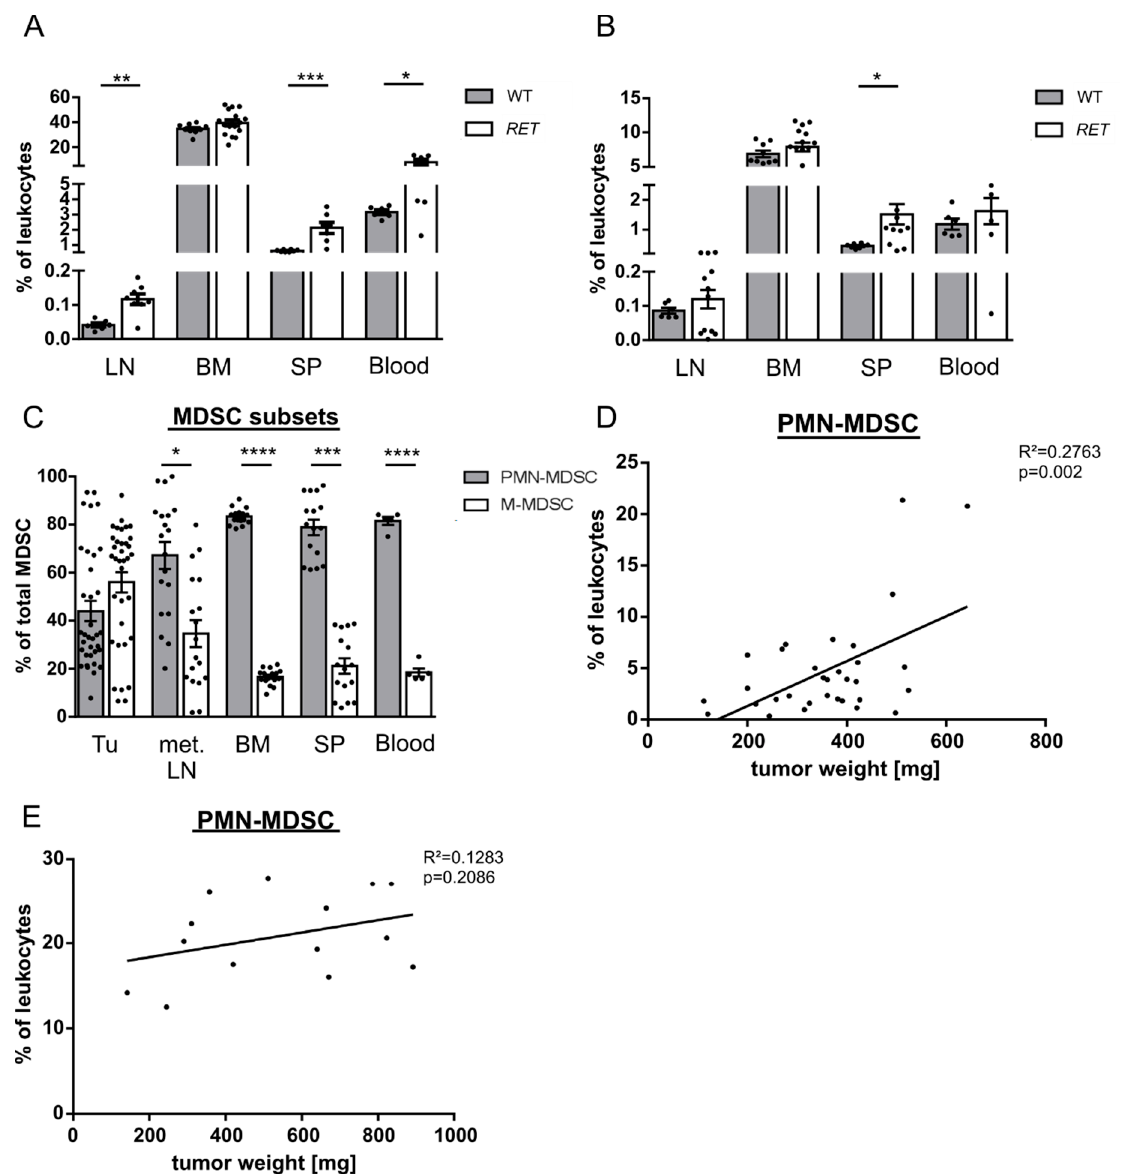
Figure 1. Myeloid-derived suppressor cells (MDSC) subpopulations in mice bearing melanoma or mesothelioma and their non-suppressive counterparts in healthy C57BL/6 mice. CD11b + Ly6G + Ly6C lo polymorphonuclear (PMN)-MDSC ( A ) and CD11b + Ly6G - Ly6C hi M-MDSC ( B ) of RET transgenic mice and their non-suppressive counterparts in C57BL/6 mice ( A , B ) were analyzed in lymph nodes (LN), bone marrow (BM), spleen (SP), and peripheral blood by flow cytometry. Data are presented as the percentage of PMN- or monocytic (M)-MDSC from tumor-bearing mice or their non-suppressive counterparts from healthy mice within CD45 + leukocytes (mean ± SEM; n = 6–16 mice/group). All samples were collected from tumor bearing mice in different time points between the appearance of macroscopically visible tumors and the appearance of abortion criteria. ( C ) PMN- and M-MDSC were measured in primary tumors (TU), metastatic LN (met. LN), BM, SP, and peripheral blood of RET transgenic mice and expressed as the percentage of PMN- or M-MDSC within total MDSC (mean ± SEM; n = 5–35 mice/group). The weight of each melanoma ( D ) or mesothelioma samples ( E ) in mg was plotted against the percentage of PMN-MDSC among CD45 + leukocytes in tumors from respective mice ( n = 14–32). The correlation was evaluated by a linear regression analysis. * p < 0.05, ** p < 0.01, *** p < 0.001, **** p < 0.0001.